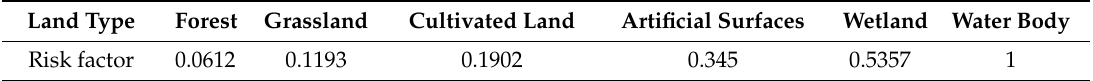
Table 3. Factor of land cover types.